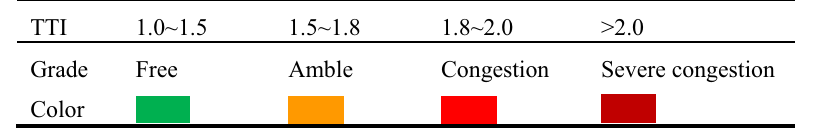
Table 2. The classification of traffic congestion